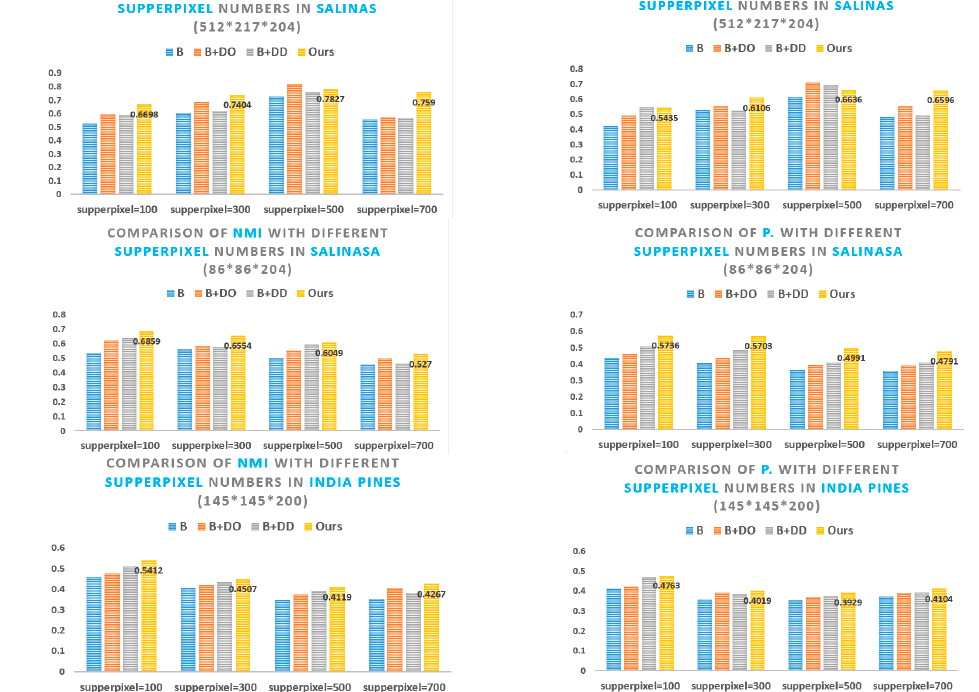
Figure 3. Classification results with different superpixels.